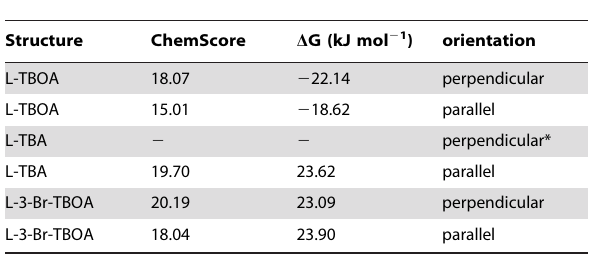
Table 1. Computational docking